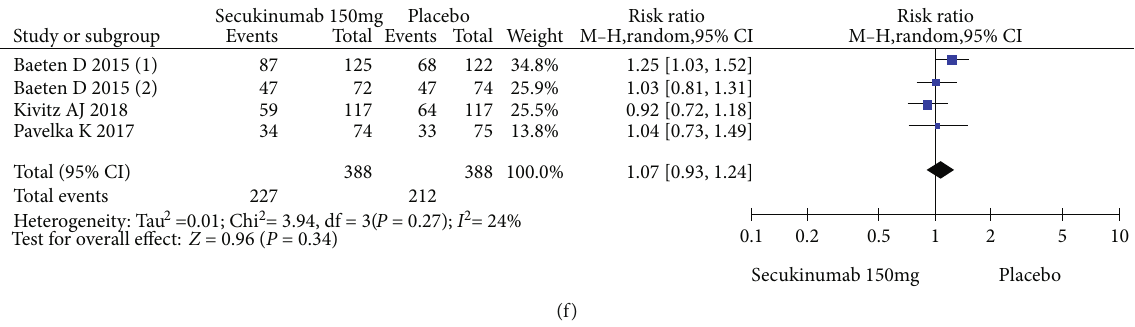
Figure 3: Meta-analysis of secukinumab 150 mg versus placebo at week 16. (a) ASAS 20 response, (b) ASAS 40 response, (c) ASAS 5/6 response, (d) SF-36 PCS score (change from baseline), (e) ASQoL score (change from baseline), (f) AEs. Baeten 2015 (1): MEASURE 1 study, Baeten 2015 (2): MEASURE 2